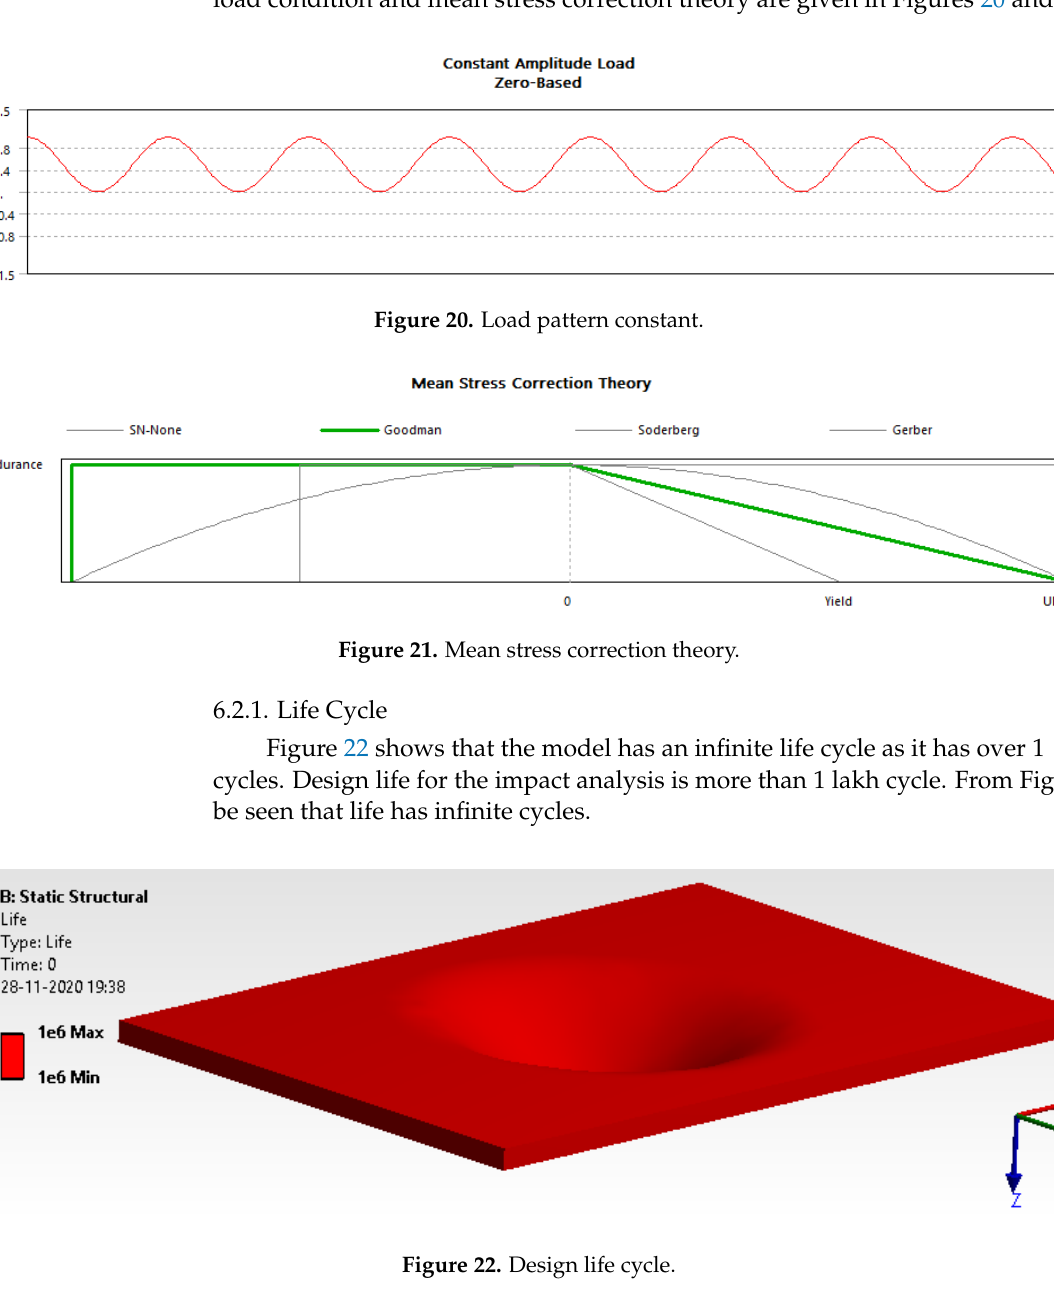
Figure 22. Design life cycle.